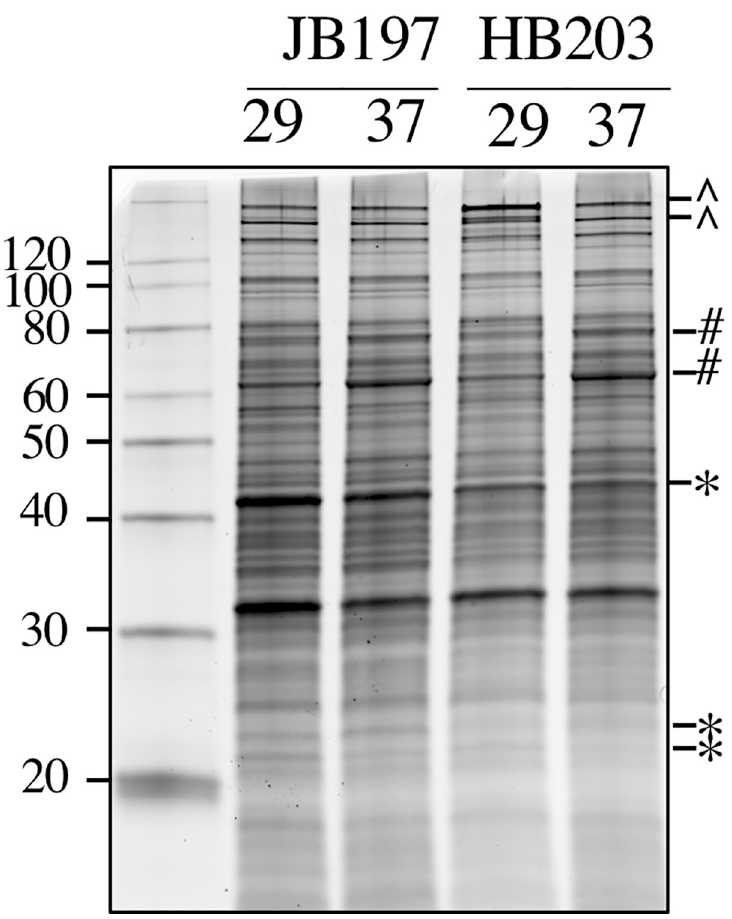
Fig 1. Total protein (5 μ g) produced by serovar Hardjo strain JB197 and strain HB203 at 29 or 37˚C. � indicates proteins increased in JB197 compared to HB203. ^indicates proteins increased in HB203 compared to JB197. # indicates proteins increased at 37 compared to 29˚C. Molecular mass markers (kDa) are